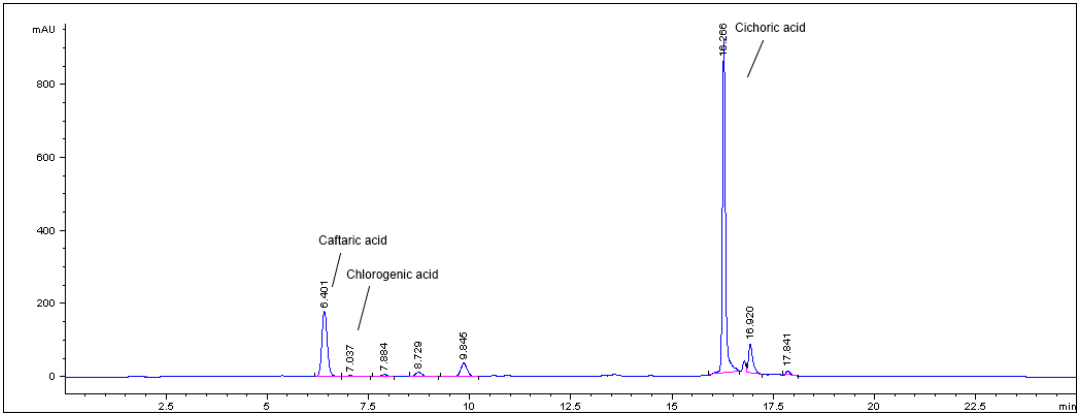
Figure 5. An example of a chromatogram (run 21) recorded at 330 nm.